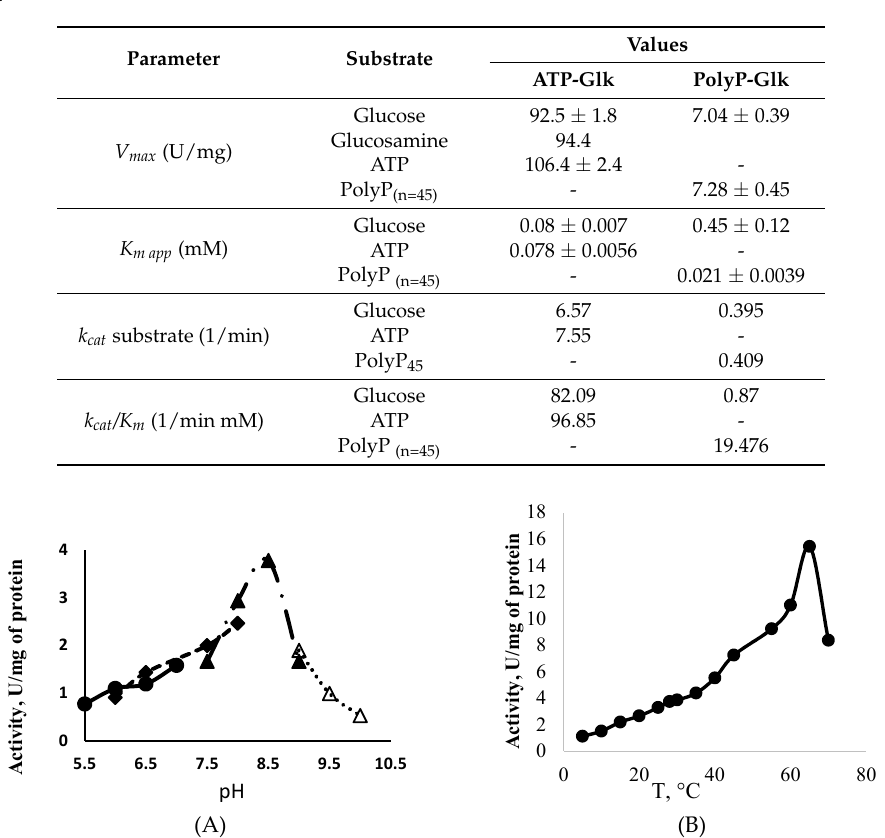
Table 2. Kinetic parameters of ATP- and polyphosphate-dependent glucokinases from Methylomonas sp. 12.